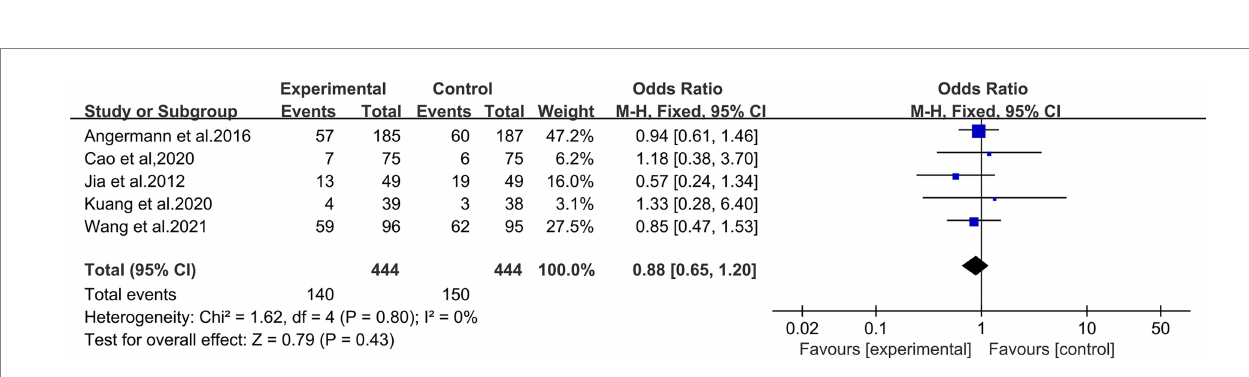
FIGURE 10 Forest plot comparing the levels of adverse reactions between the two groups.